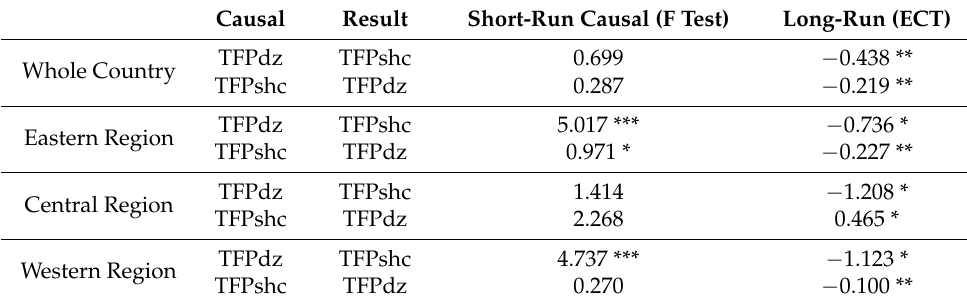
Table 5. The results of the panel Granger causality test.